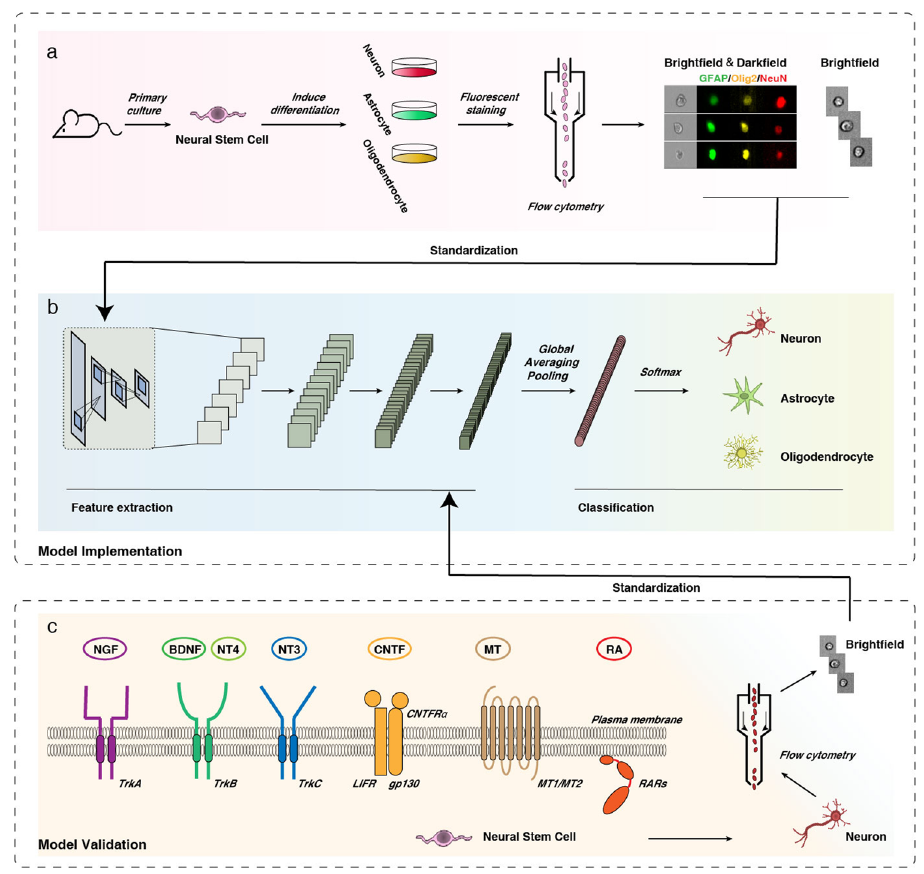
Fig. 1 Overview of work fl ow. a NSCs were induced to differentiate into neurons/astrocytes/oligodendrocytes, and the cells were stained with NeuN (red)/ GFAP (green)/Olig2 (yellow), collected and subjected to image fl ow cytometry. b Bright fi eld and dark fi eld (labelled) single-cell images were used as training data for the screening system; a schematic of the convolutional neural network (CNN) is presented. c Various inducers in different forms that act on different pathways were used to guide NSCs to differentiate into neurons, and bright fi eld (unlabelled) single-cell image patches were obtained by fl ow cytometry. These independent test sets were evaluated with the deep network model to show its